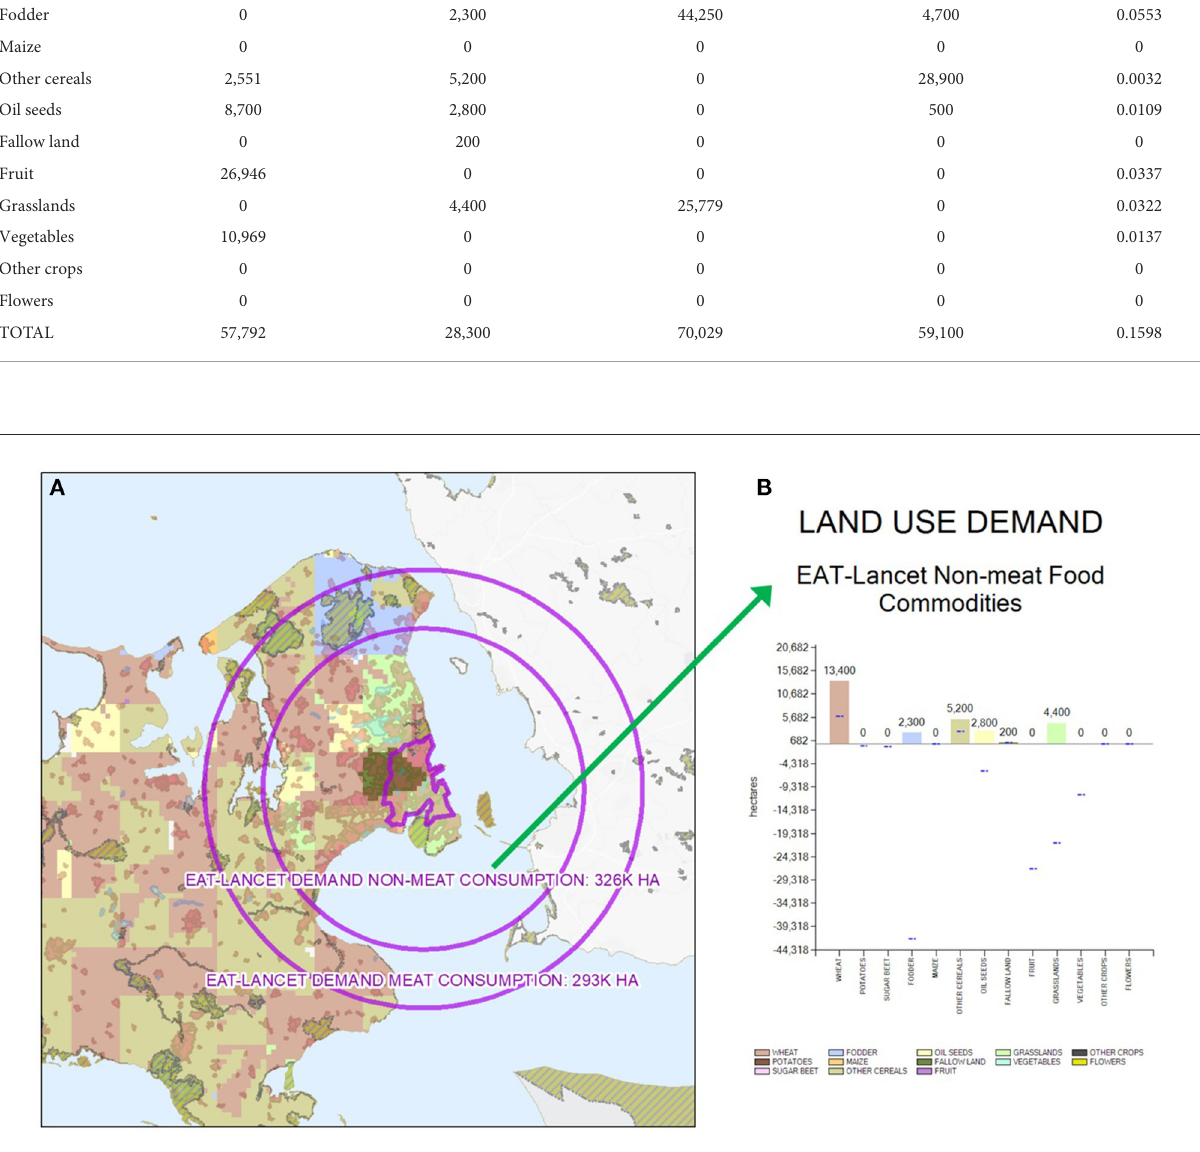
low carbon circular future, including a shift to less